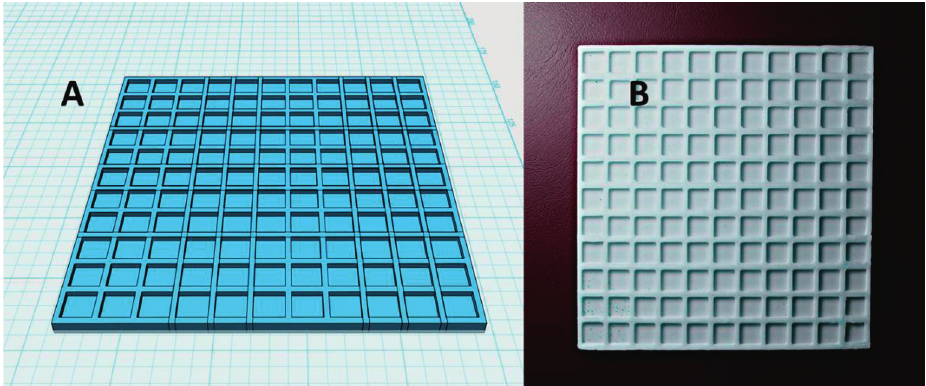
Figure 1: Photographs of the 3D-printed pad: project (a) and final printed pad from acrylonitrile butadiene styrene